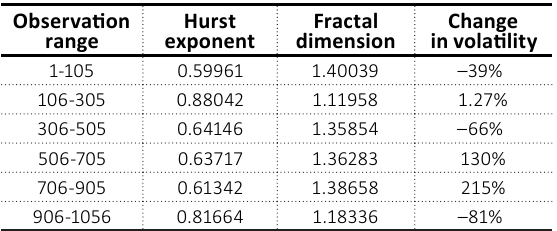
Table 2. GHE output Table 3. Fractal geometry and topology